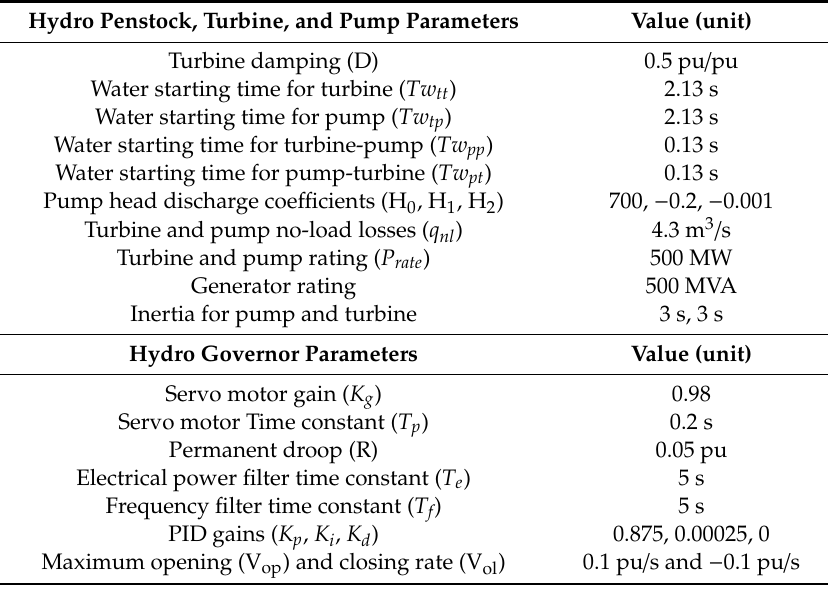
Table A1. Parameters for the hydraulic governor turbine